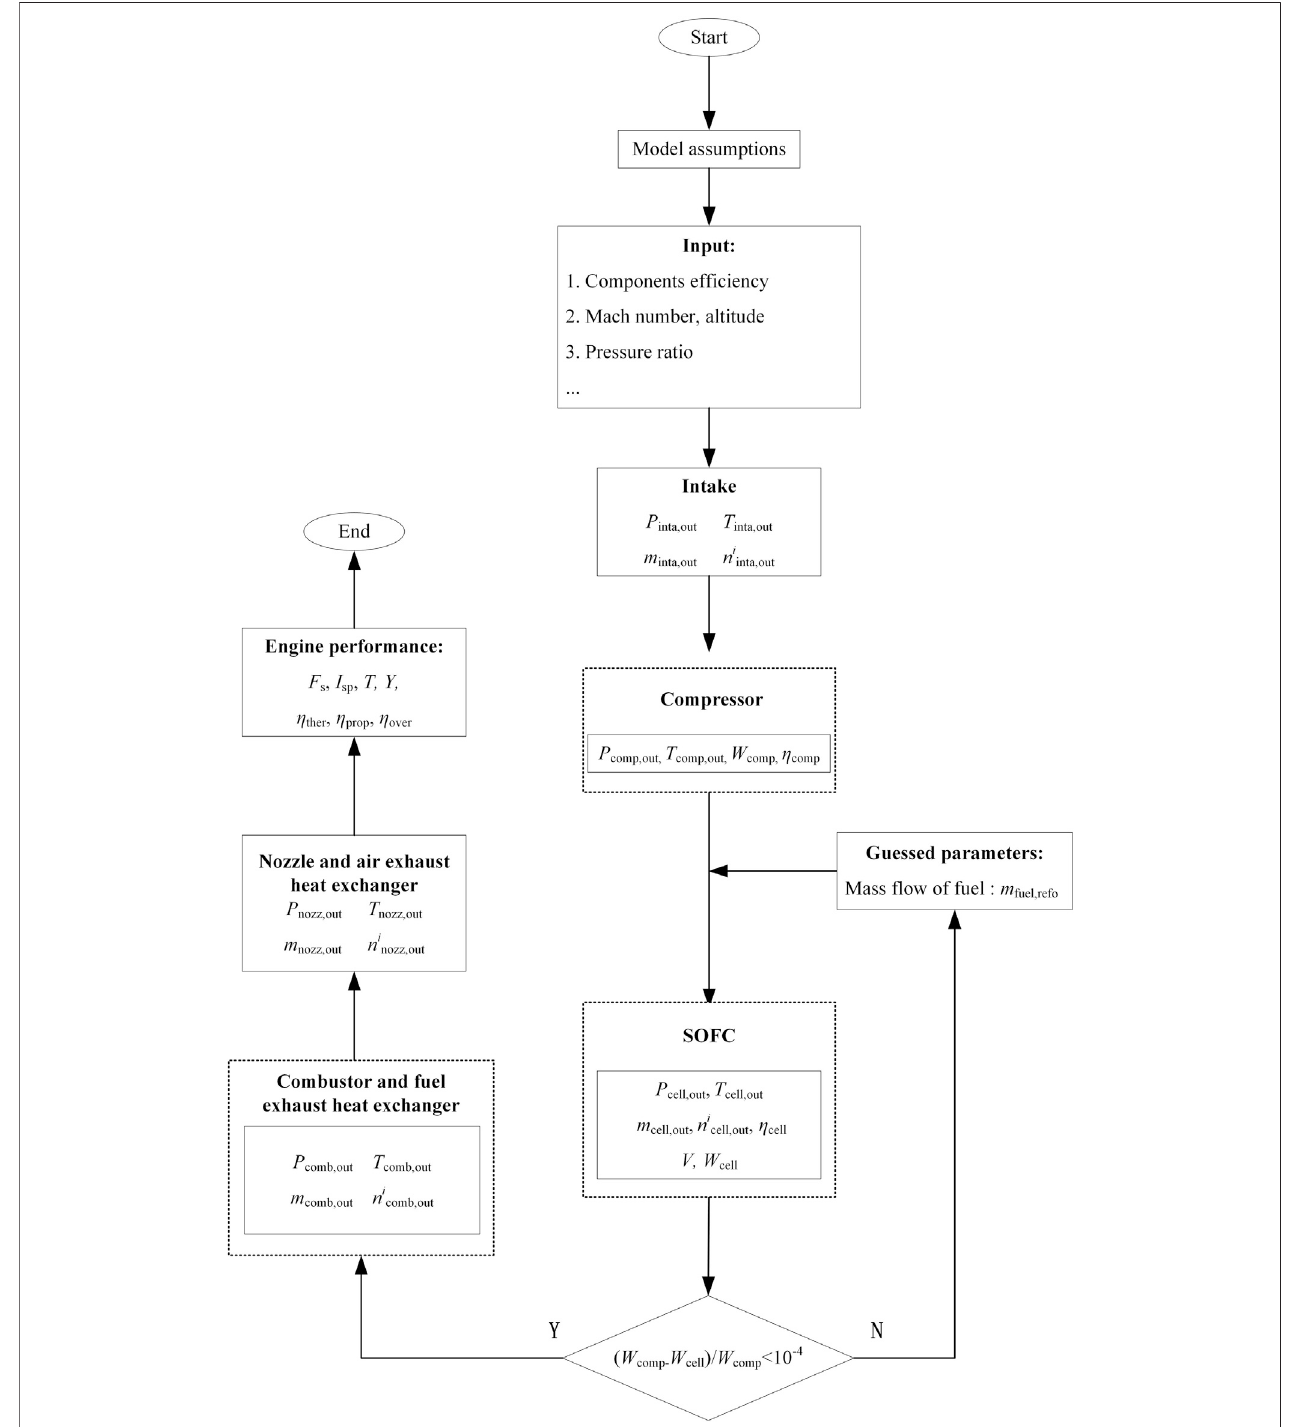
FIGURE 4 | Flowchart of the HEFC engine